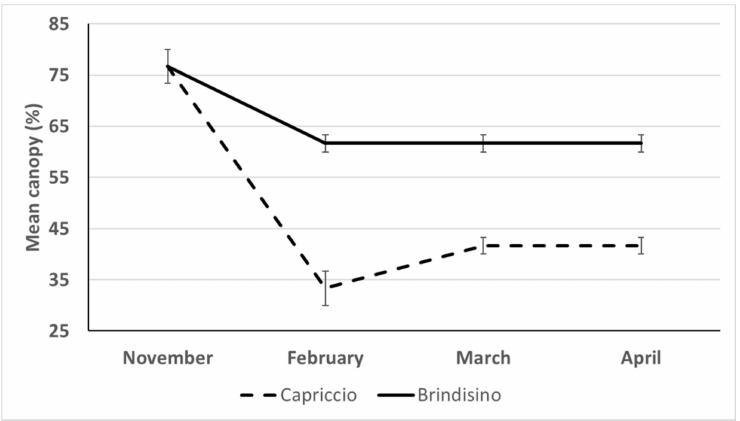
Figure 3. Monthly estimated canopy of T. subterraneum for each variety. The standard error is indicated for each point of the graph.